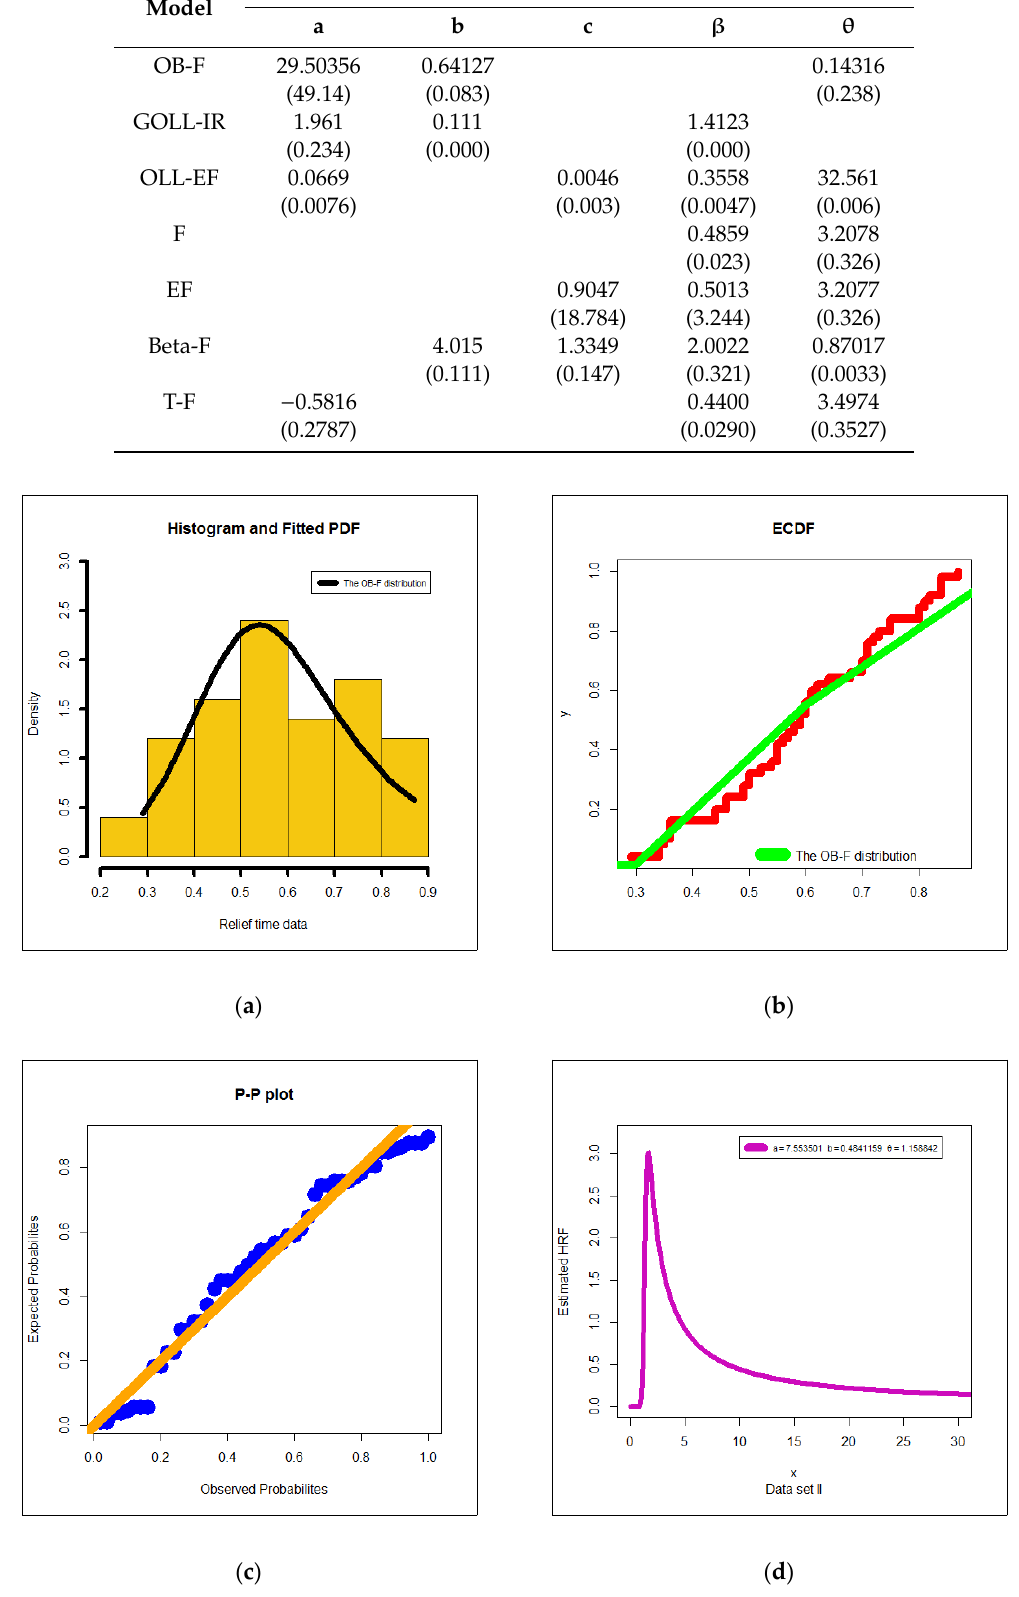
Figure 7. ( a ) Estimated density; ( b ) estimated CDF; ( c ) P-P plot; ( d ) estimated HRF for data set III . 7. Validation under Censored Scheme